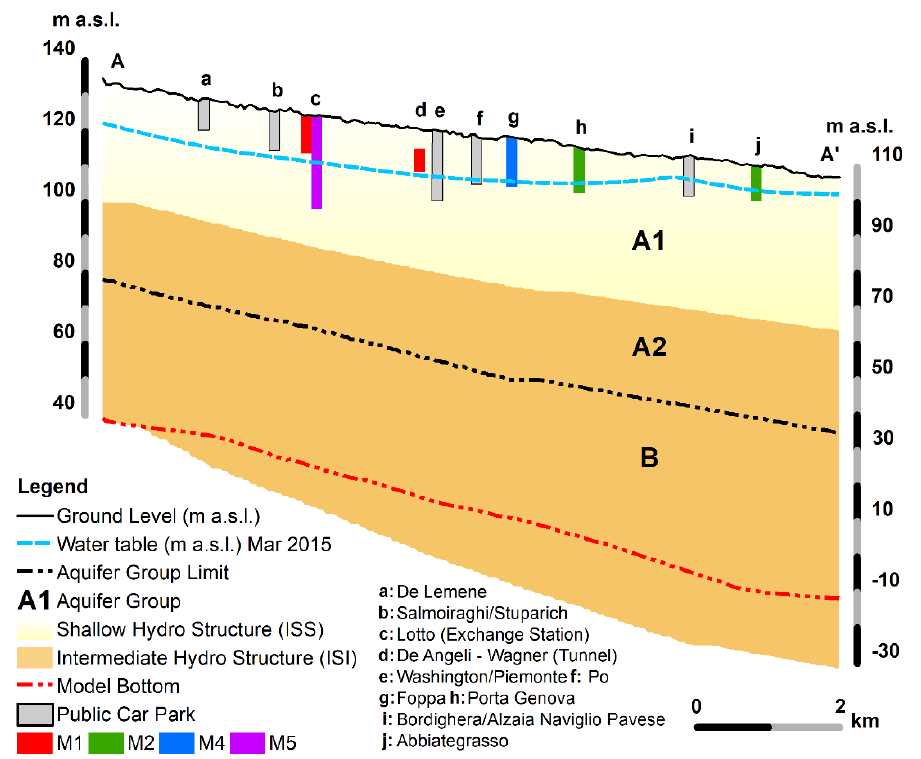
Figure 2. Hydrogeologic schematic cross sections AA’ (N–S) of the study area, showing the location of some UIs and their relationship with the groundwater condition of Mar 2015 [51]. For their location on map, please refer to Figure 1.